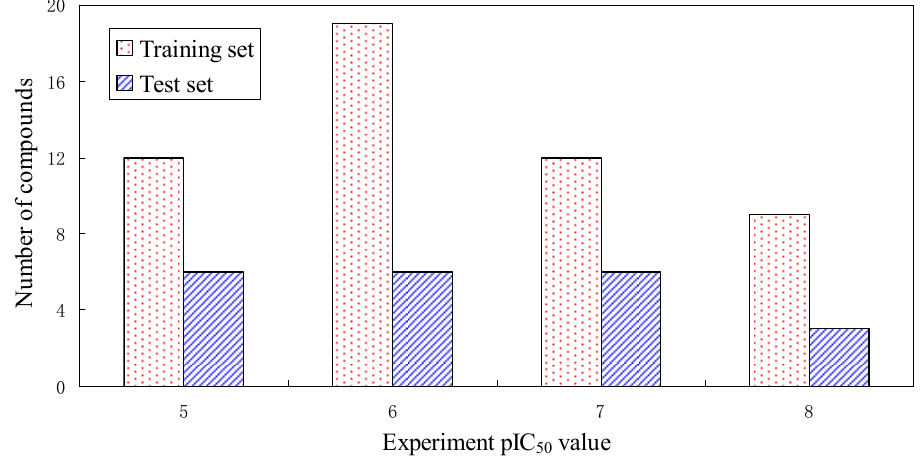
Figure 10. Distribution of activities (pIC50) for the training set and the test set versus numbers of compounds. The training set and the test set are colored as red and blue,